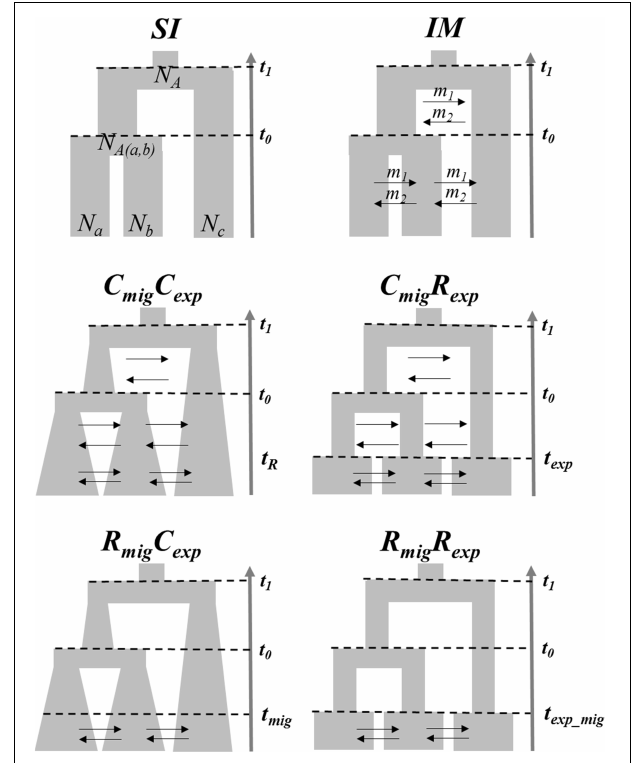
FIGURE 1 | Speciation models among the three Anastrepha species compared by the ABC approach. A model under a strict isolation (SI) was first compared with an isolation with migration model (IM). These two speciation models were compared in the presence of the three alternative models of topology. t 0 is the number of generations since the first speciation event (backwards in time) while t 1 corresponds to the second speciation event. N a , N b and N c are effective populations sizes for each species. N A ( a , b ) is the ancestral population size of a and b while N A is the ancestral population size of the common ancestor for the three species. Bidirectional migration rates m 1 and m 2 are the proportion of migrants per generation. Once the more likely topology was confirmed under an IM model, four models were further compared using MIGRATE and IMa2 results as priors by a second ABC analysis in order to test for temporal patterns of migration and population expansion (continuous vs recent). A model with constant migration and population expansion C mig C exp , a model with constant migration and recent population expansion C mig R exp , a model with recent migration and constant population expansion R mig C exp , and a model with recent migration and population expansion R mig R exp . The parameters t exp , t mig and t exp_mig represent the time (3,000 generations) since the species experienced population expansion, migration or both after a period of strict